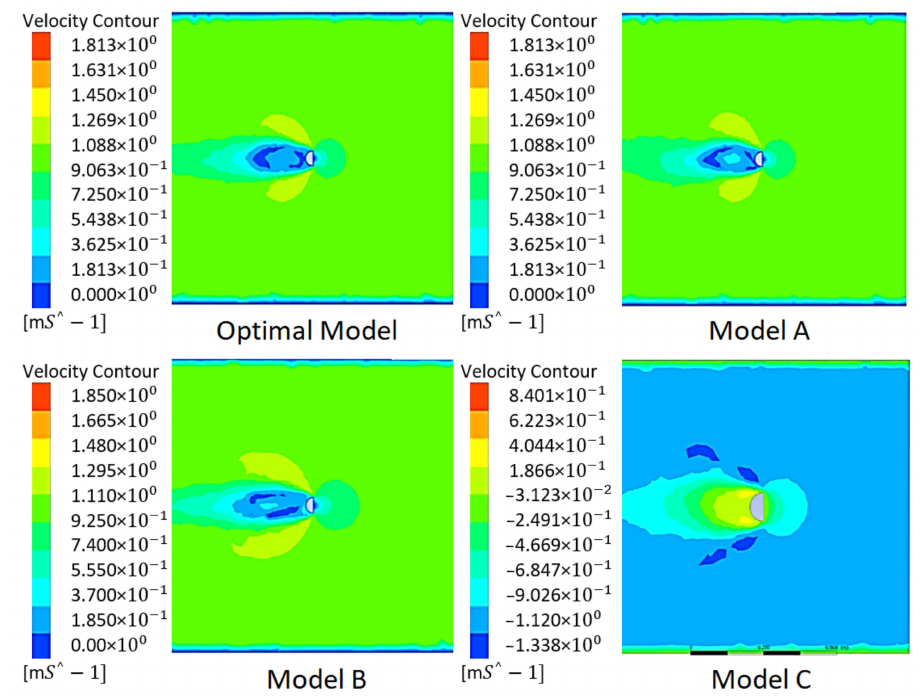
Figure 20. Side Force Plots for Different Models.